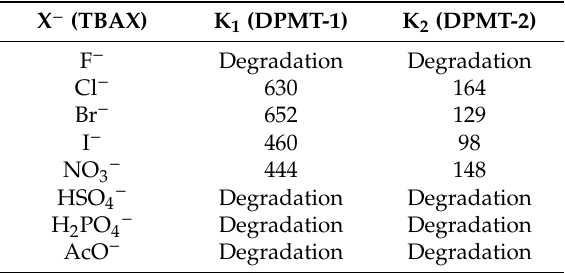
Table1. Apparentassociationconstantsforthebindingofvariousanionsto DPMT-1 and DPMT-2 inCDCl 3 . X −